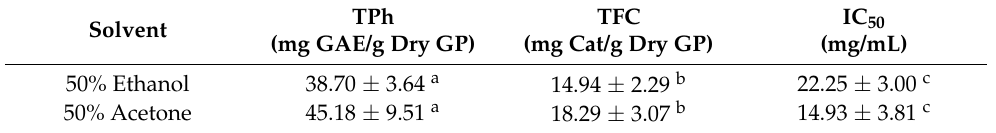
Table 3. Total phenolic content, total flavonoid content, and reducing capacity (mean ± standard deviation) of grape pomace ethanol and acetone extraction at optimized